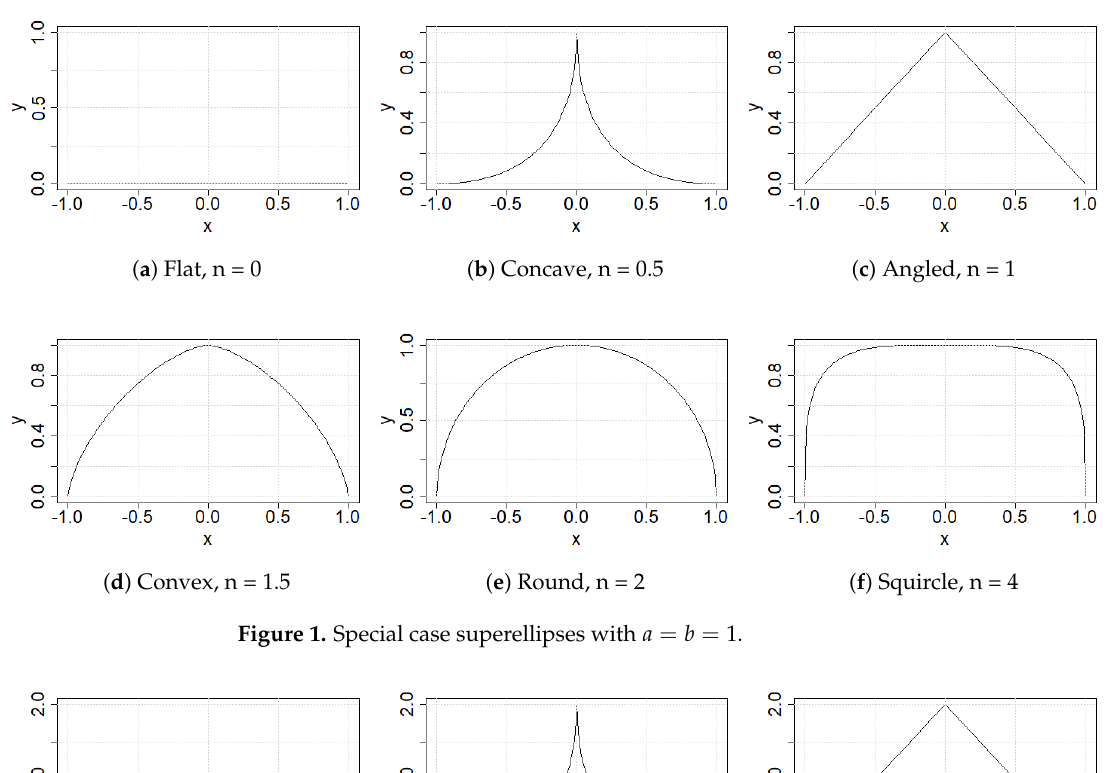
Figure 1. Special case superellipses with a = b = 1.